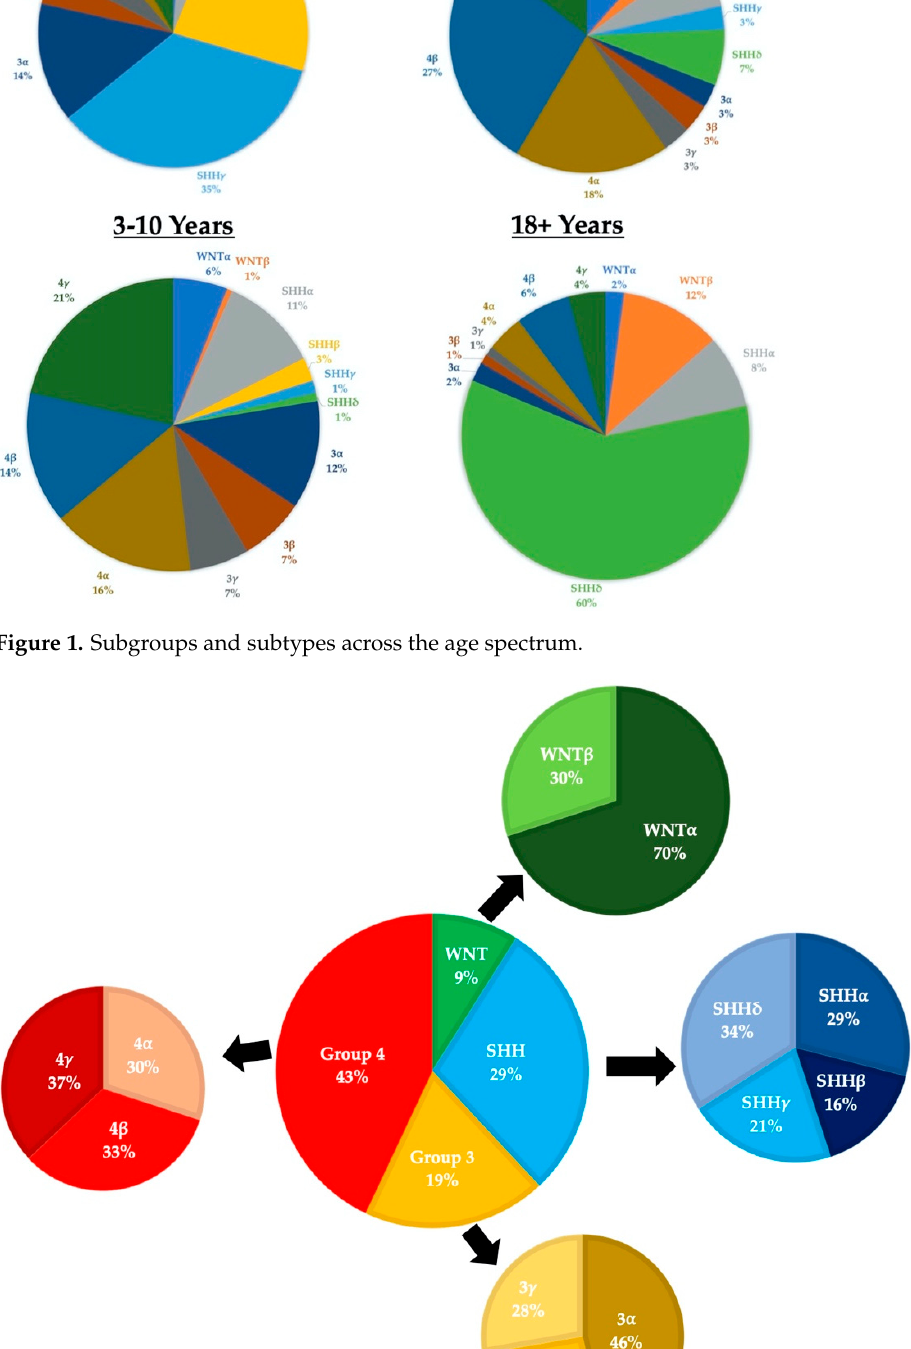
Figure 2. Medulloblastoma molecular subgroups and subtypes pie charts are based on data from Cavalli (2017). This series included 763 patients, of which 101 were adults [9] .